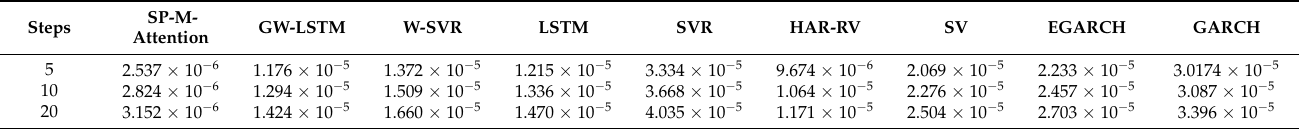
Table 4. Comparison errors (MSE) of multi-step ahead prediction between SP-M-Attention and other baseline methods. Steps SP-M-